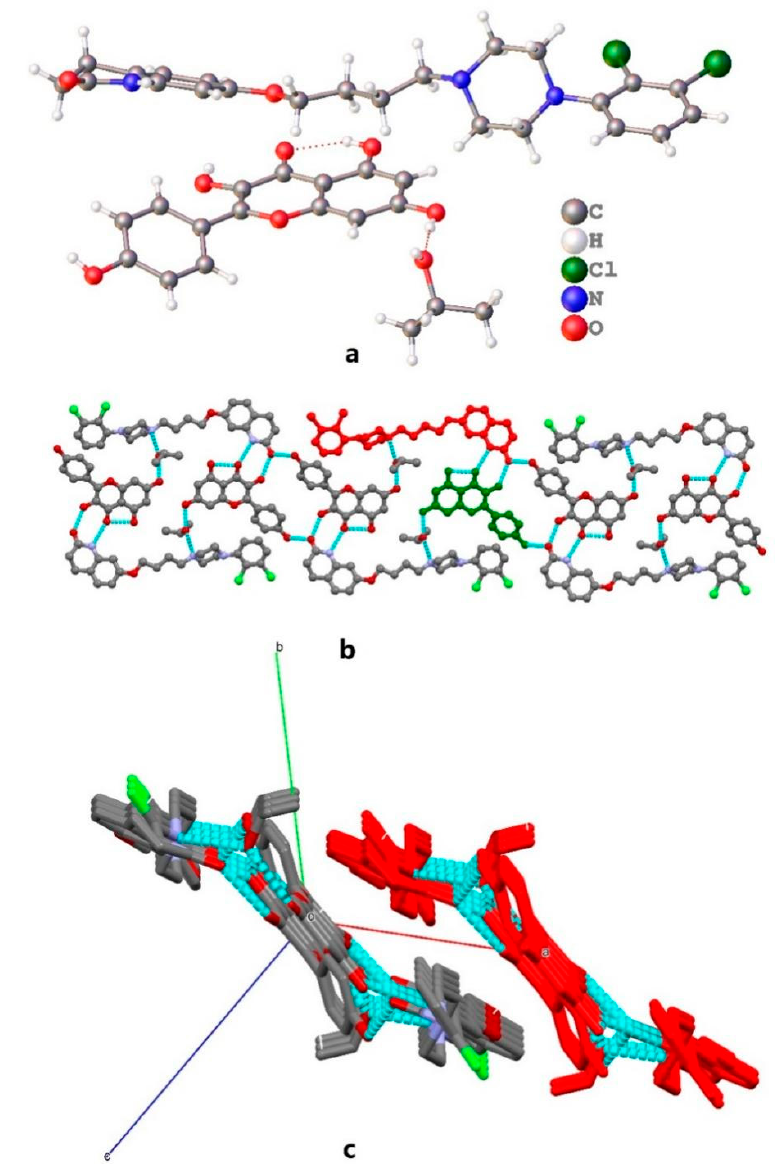
Figure 4. ( a ) The asymmetric unit for ARI-KAE·EtOH, ( b ) hydrogen bonds, ( c ) two parallel hydro- gen bonds chain along [111]